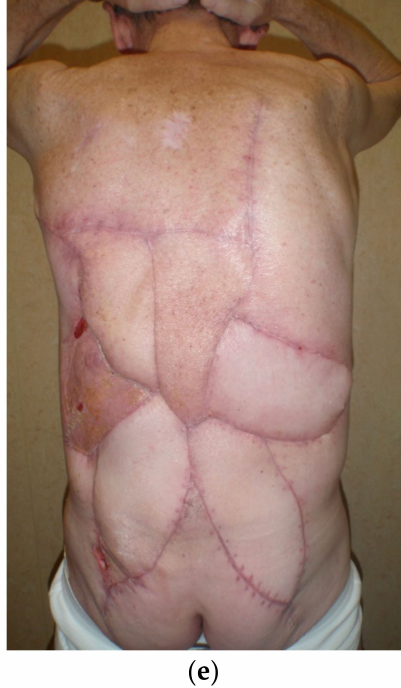
Figure 11. ( a ) Recurrence of squamous cell carcinoma infiltrating the deep planes; ( b ) a soft tissue defect (28 × 19 cm) with exposure of the spinal cord resulting from the tumor excision; ( c ) 6 propeller flaps were raised on perforators from the posterior intercostal and lumbar networks; ( d ) skin grafting was needed in only 1 donor site; and ( e ) the result at 4 months